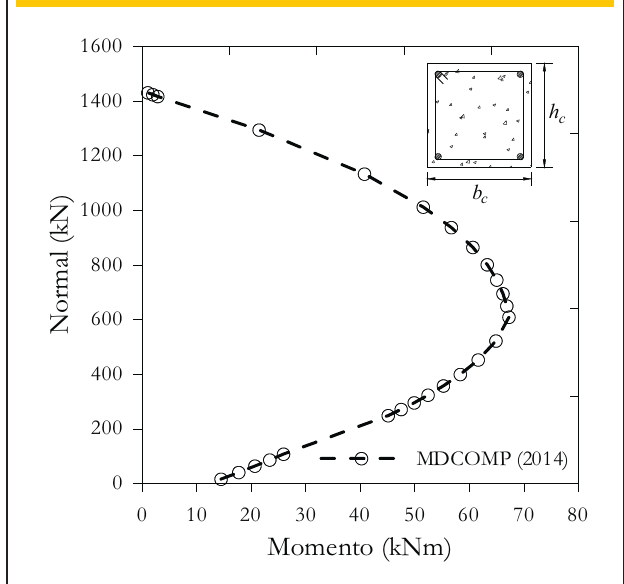
Figure 5 – Interaction curve of the cross–section of a reinforced concrete column